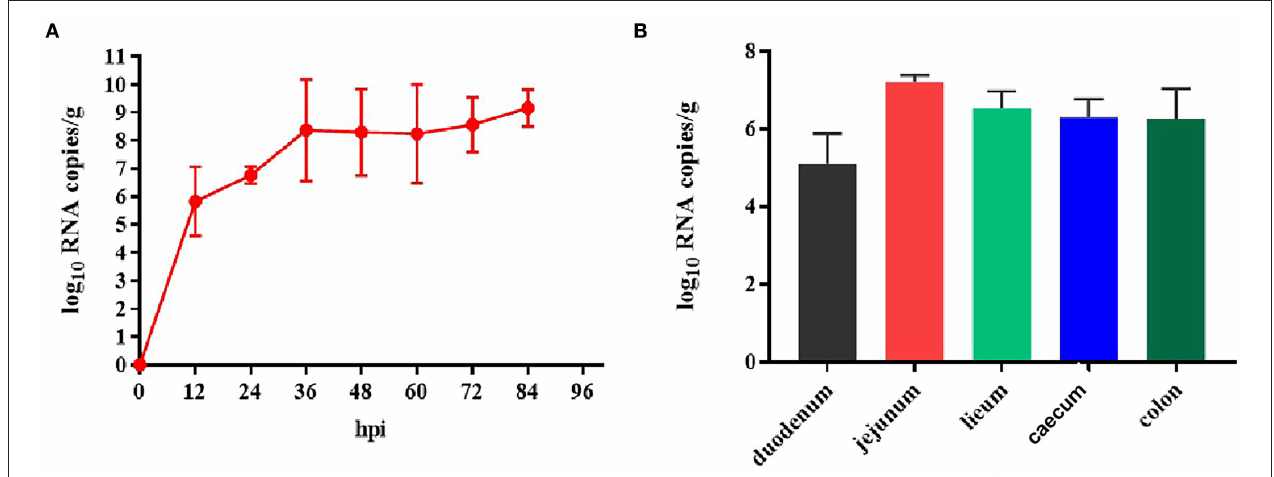
FIGURE 7 | Reproduction of watery diarrhea and viral shedding in newborn piglets inoculated with TGEV HQ2016 via oral feeding. (A) Quantification of viral RNA levels of fecal samples of piglets inoculated with TGEV HQ2016. (B) Quantification of viral RNA levels in intestine tissues of piglets at 84h inoculated with TGEV HQ2016.